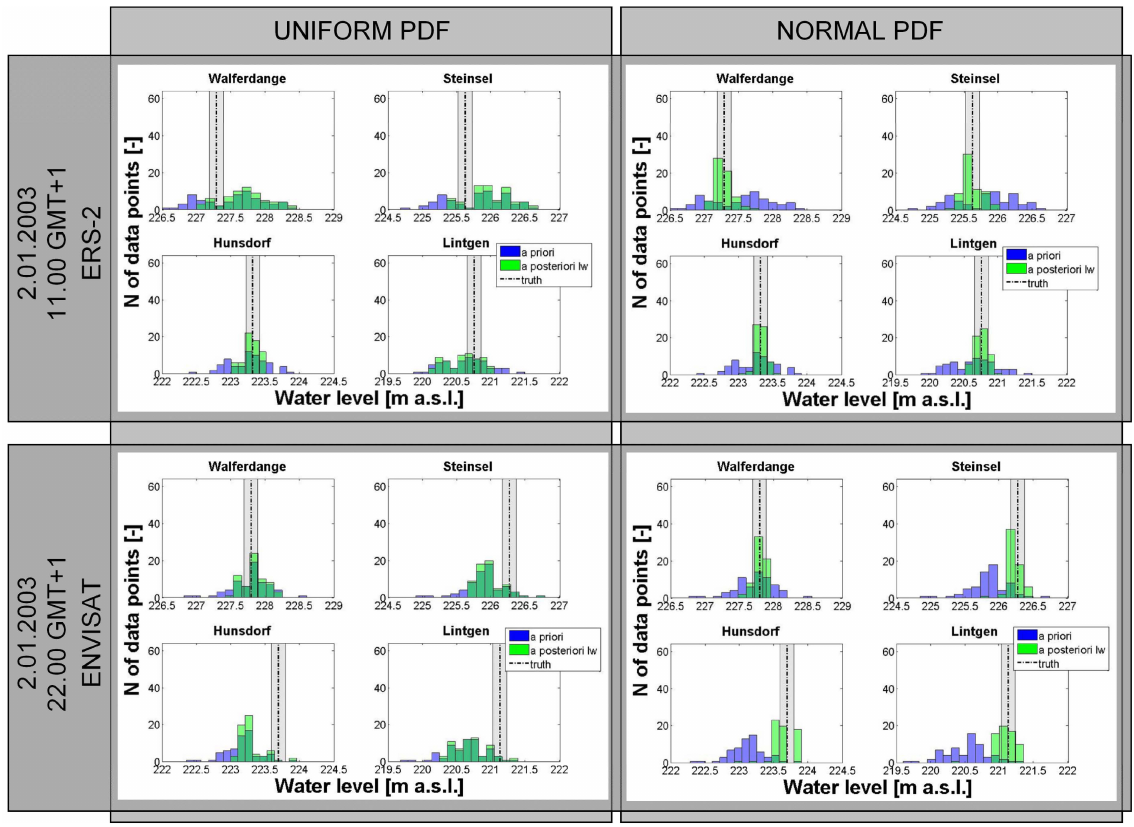
Fig. 10. Idem Fig. 8, but applying the local weighting approach for every location along the river (lw: local